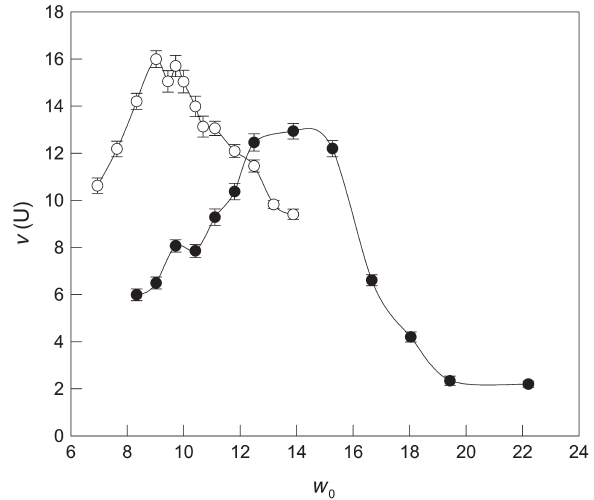
Figure 2. Effect of micellarwater content( w 0 = [H 2 O]/[surfactant])on activity of p NPPase from H. salinarum in reverse micelles (0.2 M CTAB and 1 M 1-butanol in cyclohexane) with 1 M NaCl ( (cid:4) ) or 0.075 M NaCl ( (cid:5) ). The reaction was initiated by microinjection of substrate into reverse micelles containing enzyme. Reaction condi- tions:[ p NPP] = 172 mM in 100 mM Tris-HCl buffer, pH 8.5, contain- ing 20 mM 2-mercaptoethanol and 5 mM MnCl 2 ; temperature = 40 °C; protein concentration = 0.6 µg ml –1